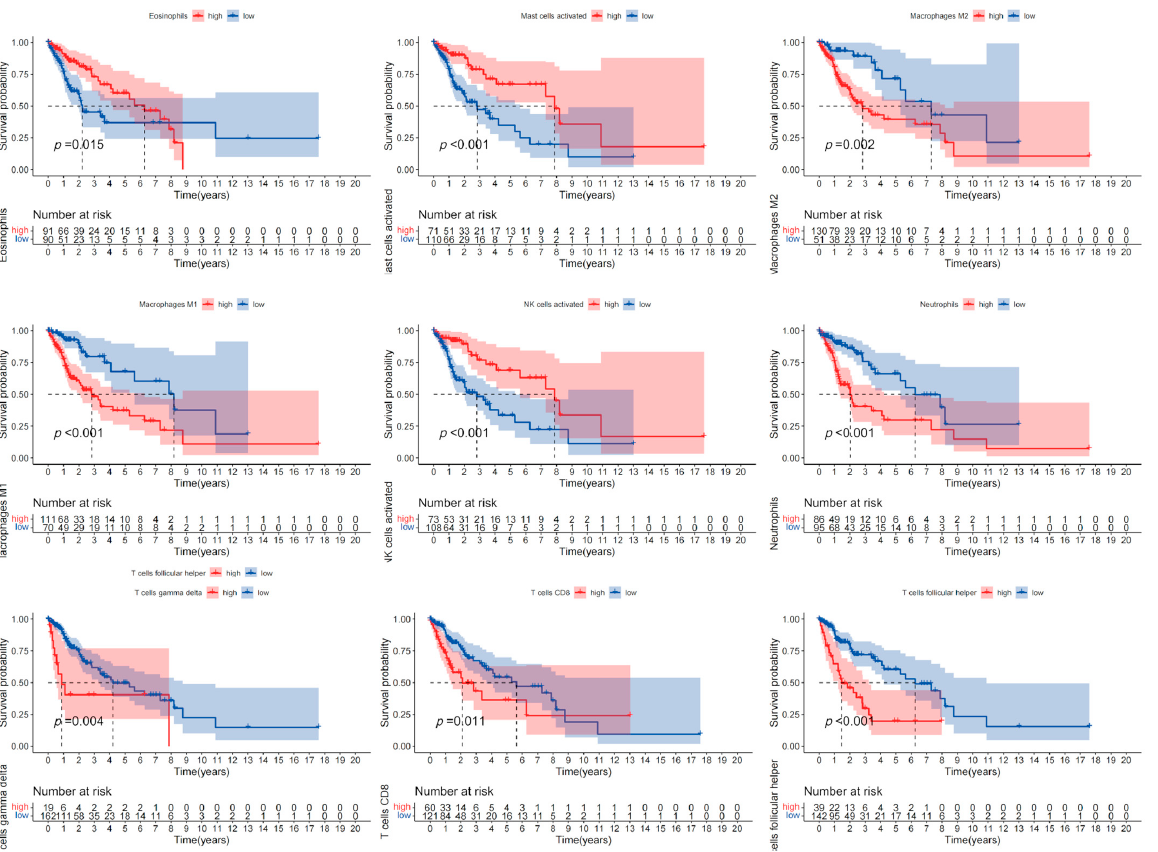
Figure A5. Kaplan–Meier curves of TIICs associated with prognosis of glioma.